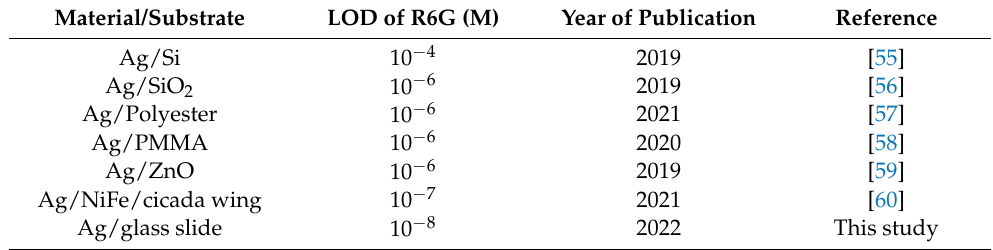
Table 7. A comparison of the R6G LODs detected on a single silver SERS substrate deposited by sputtering methods in several studies over the last three years .